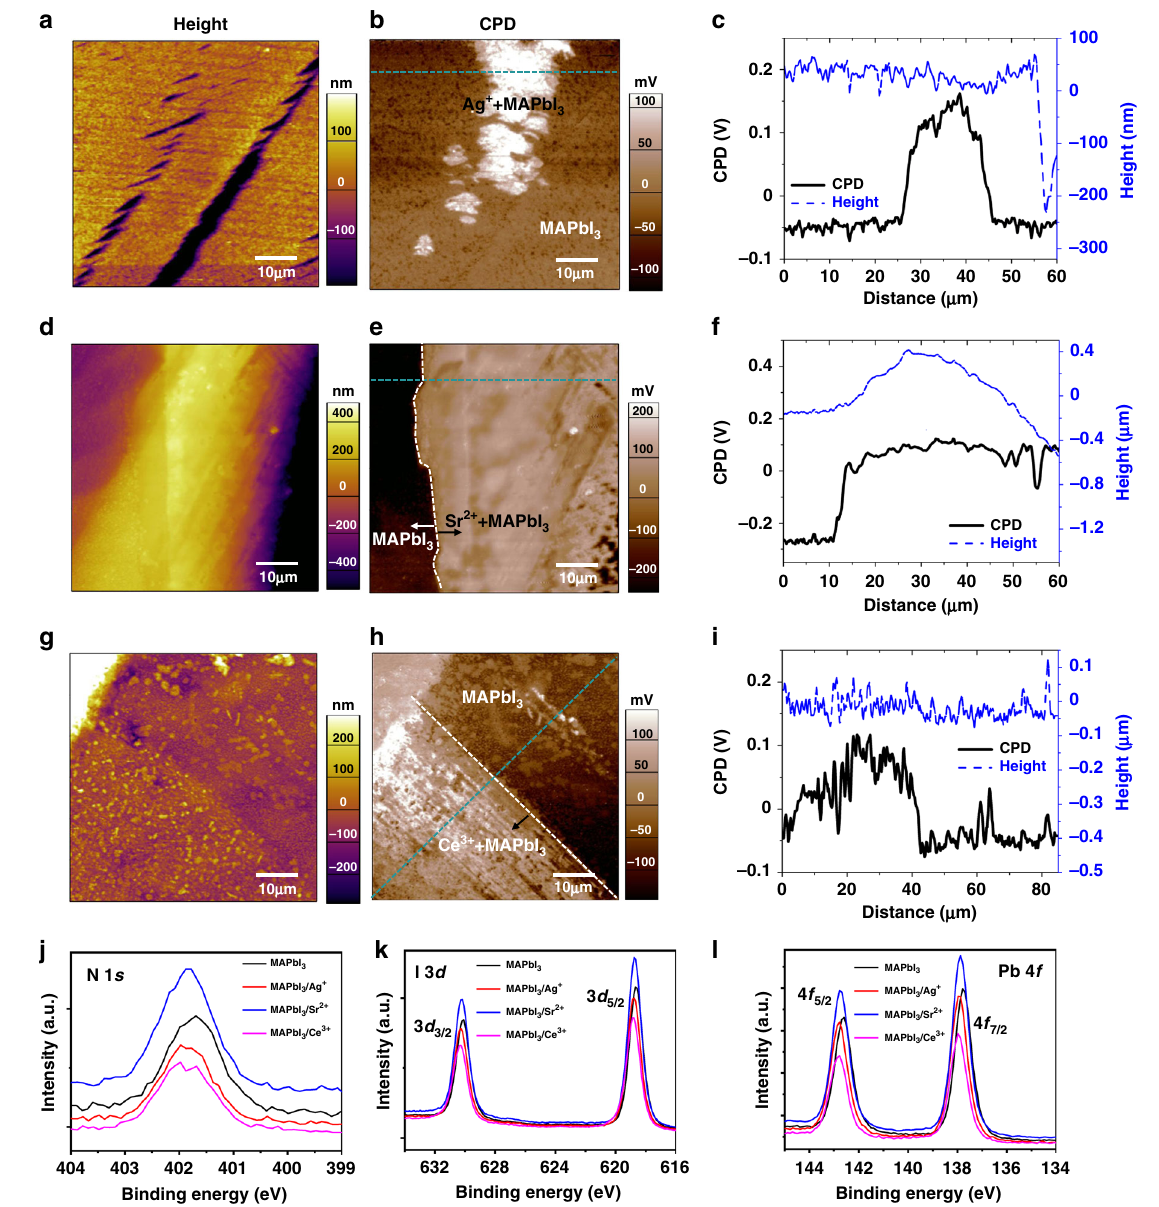
Fig. 2 Doping type of perovskite surface doping. Height, CPD images and cross sectional curves of a – c AgI, d – f SrI 2 , or g – i CeI 3 treated MAPbI 3 single- crystal surface by KPFM measurement. j – l XPS scans of the N 1 s , I 3 d , and Pb 4 f measured from the untreated MAPbI 3 and MAPbI 3 with surface treated by AgI, SrI 2 , and CeI 3